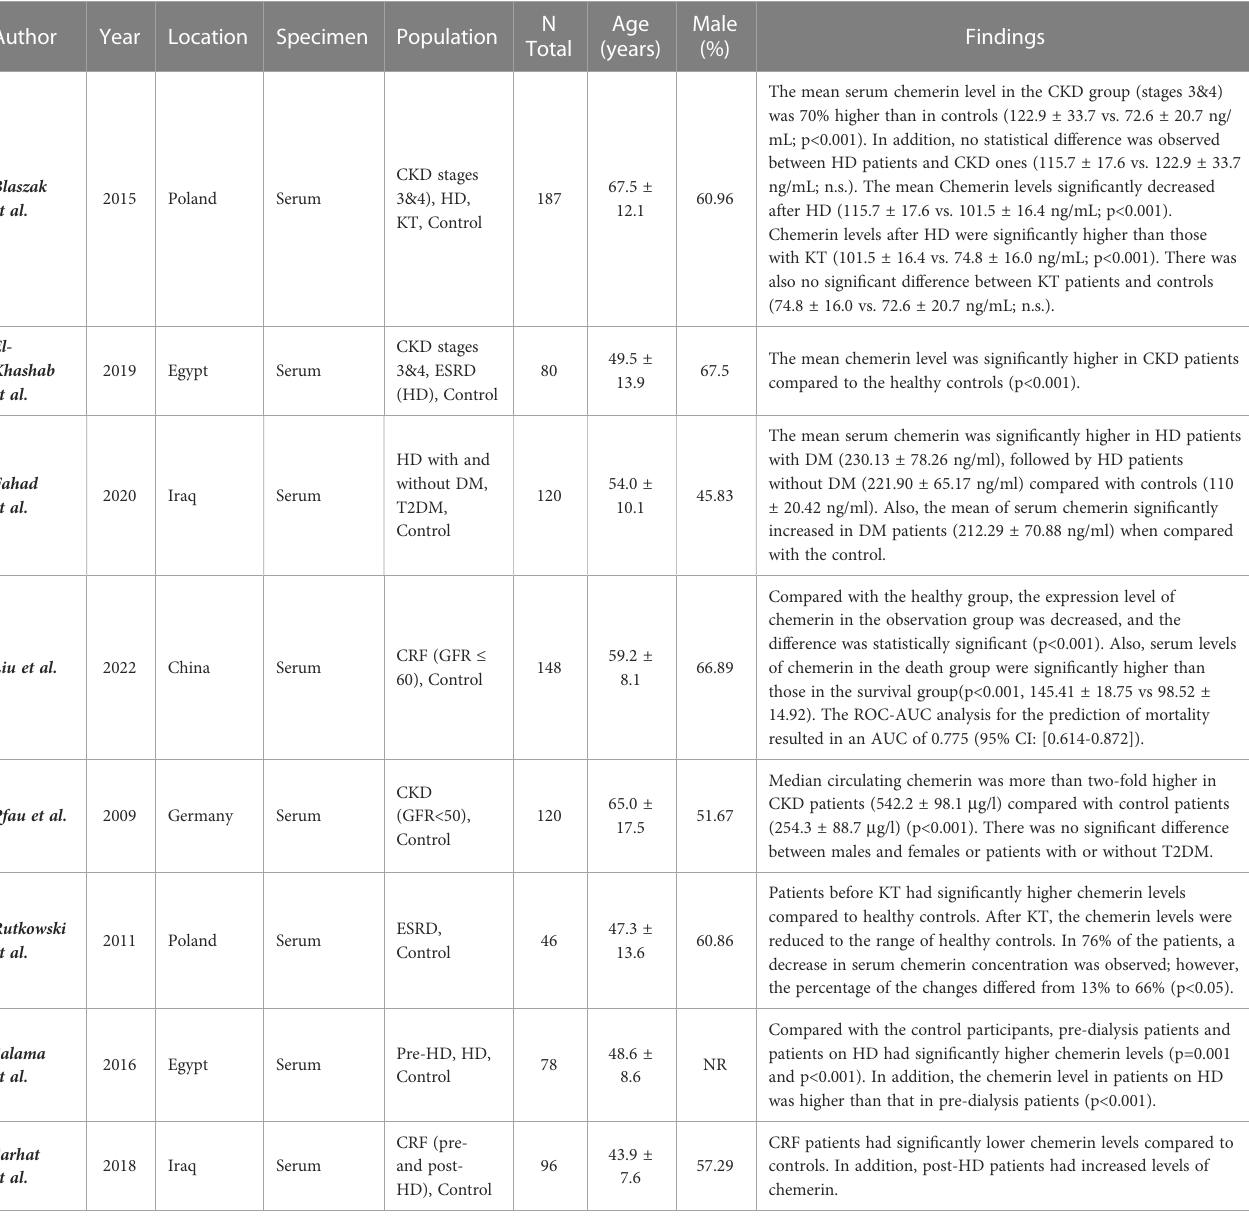
TABLE 1 Characteristics of studies evaluating the relation between chemerin levels and chronic kidney disease.